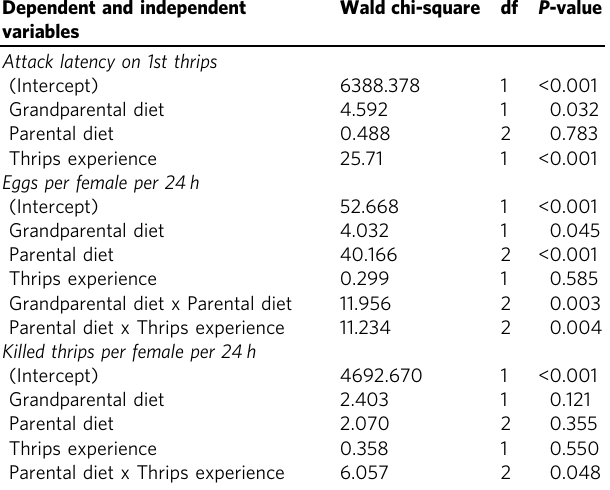
Table 1 Generalized linear models (GLMs) on the in fl uence of grandparental diet (pollen or spider mites), parental diet (pollen, live spider mites, dead spider mites) and thrips experience early in life (yes, no) on the attack latency on the 1st thrips (lg transformed; normal distribution, identity link function) and the number of thrips killed and eggs produced per female within 24 h (Poisson distribution, log-linear link function). Data are visualized in Figs. 2, 5, and 6; estimated marginal means are in Supplementary Tables 1 –